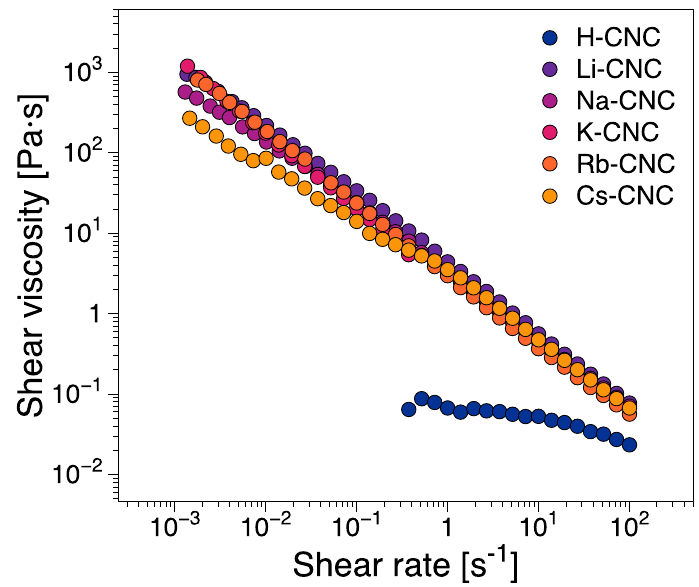
Figure 5. Steady shear viscosity functions of the CNC suspensions.